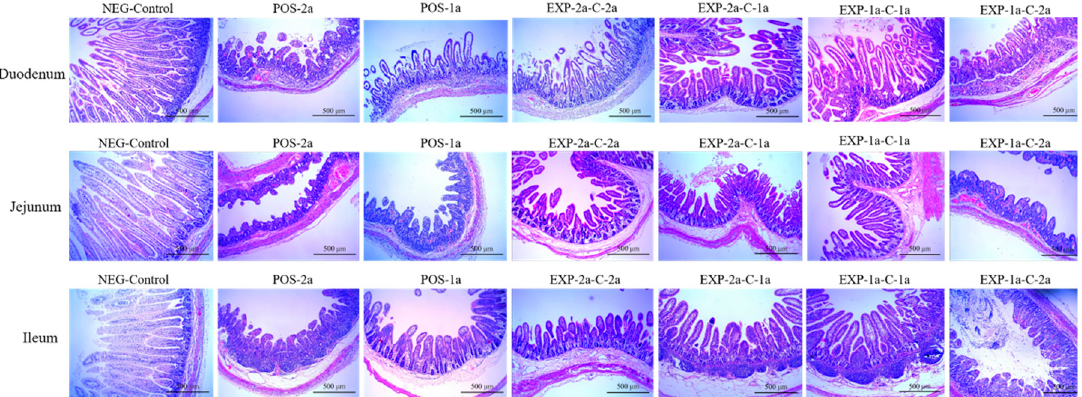
Figure 5. PEDV shedding patterns for all challenged piglets over time. For each group a line corresponds to the quantity of virus shed in rectal swabs for a single piglet from dpc 1 to dpc 7 is shown on the right side of the heatmap. 3.4. Protective Effects of Different Levels of Maternal Antibodies on Piglets The colostrum antibody responses induced by vaccinated CH/JX/01 and CV777 were assessed by a commercial indirect-ELISA kit. As shown in Figure 6, the CH/JX/01 and CV777 strains were all induced specific sIgA responses, while the titer of the sIgA stimulated by CH/JX/01 was significantly higher than that induced by CV777 at 7 days post parturition ( p < 0.01). The protective effects of two maternal antibodies against challenge with virulent homologous and heterologous virus (CH/JX/01, CV777) were set by the observation of clinical signs and mortality of the piglets during the 7-day observation period. The results indicated that maternal antibodies induced by CH/JX/01 could protect 100% (5/5) piglets against both CH/JX/01 and CV777 challenge, while the maternal antibodies induced by CV777 protected only 40% (2/5) piglets against CH/JX/01. The survival curves were in accordance with the results of cross-protection and maternal sIgA antibodies (Figure 7). No piglets in group POS-2a survived under CH/JX/01 challenge.